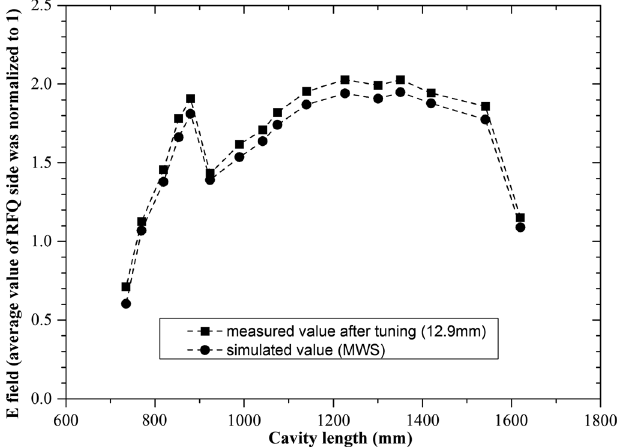
FIG. 10. The charge states from LIS, calculated position at the extraction slit shown in Fig.